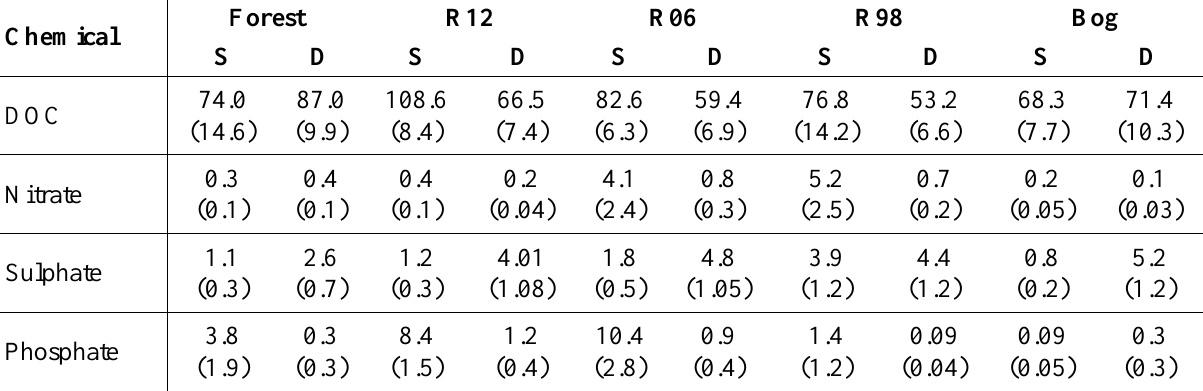
Table 2. Pore water chemical composition (mg L -1 per site) at restored sites R12 (felled in 2012), R06 (felled in 2006) and R98 (felled in 1998), at both core depths (S=Shallow and D=Deep). Standard error in brackets. Forest Chemical